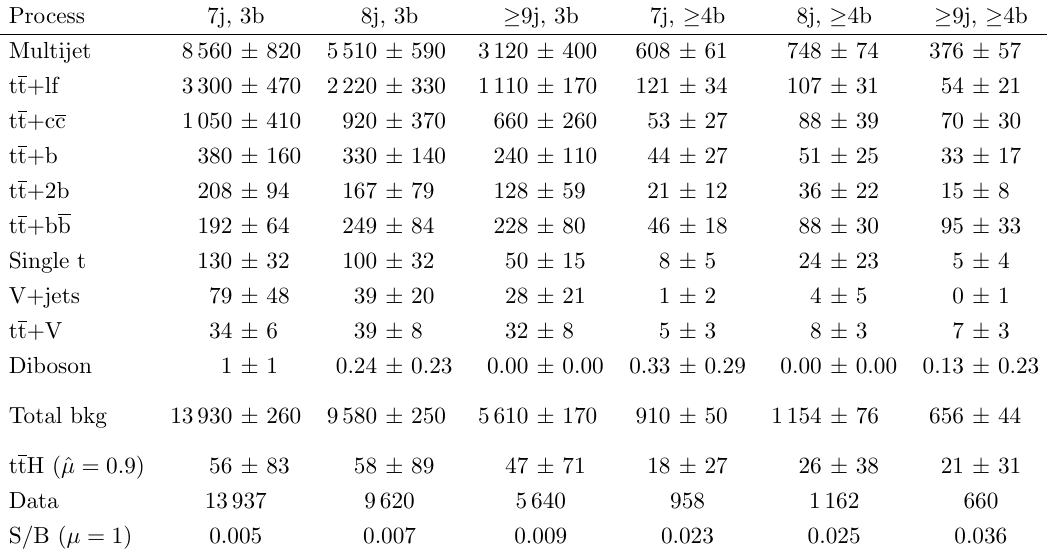
Table 4 . Expected numbers of ttH signal and background events in the last three bins of the MEM discriminant for the six analysis categories, following the (cid:12)t to data. The signal contributions are given at the best (cid:12)t value. The quoted uncertainties contain all the contributions described in section 7 added in quadrature, considering all correlations among the processes. Also given are the signal (S) to total background (B) ratios for the SM ttH expectation ( (cid:22) = 1).